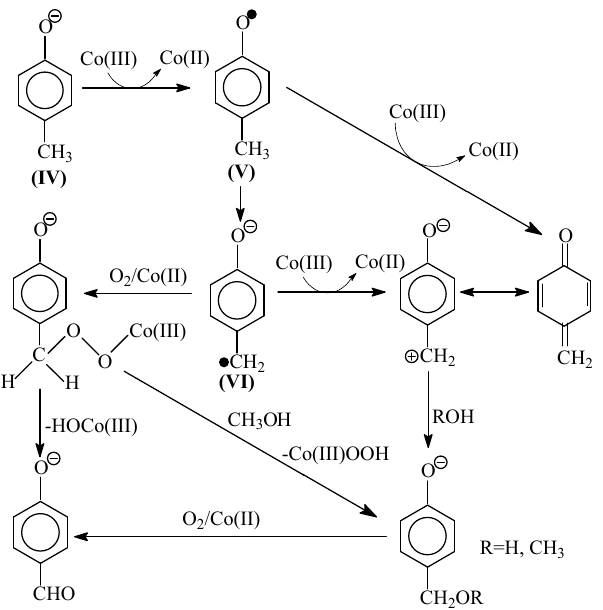
Scheme 3. The mechanism of p -cresol oxidation according to Sheldon [83]. Curved arrows show the transformations happening to the